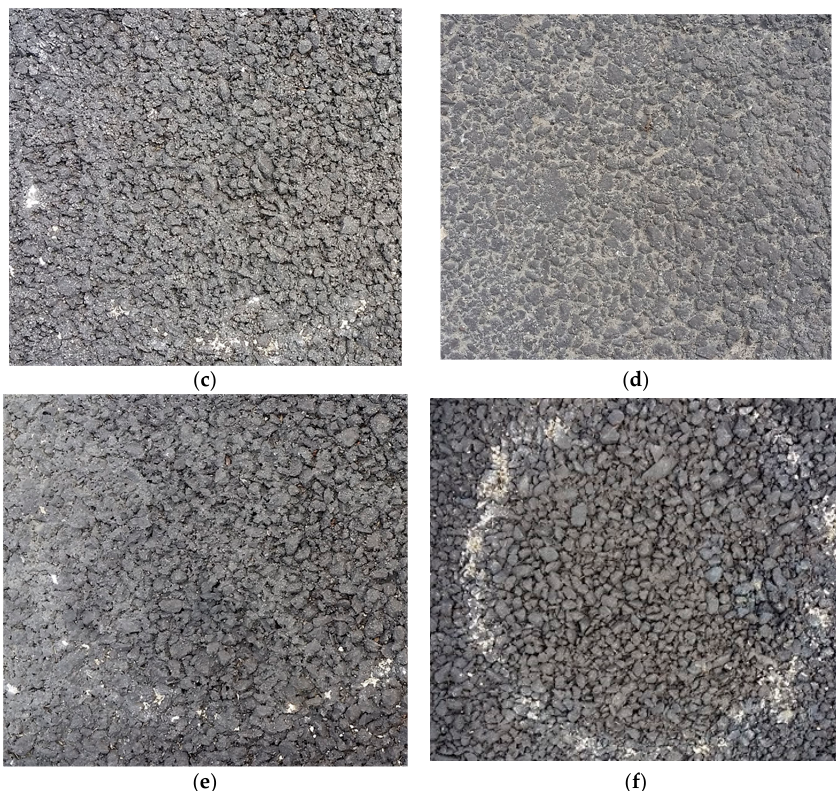
Figure 3. Images acquired with a cell phone camera of on the porous asphalt site at location 1 in ( a ), location 2 in ( b ), location 3 in ( c ), location 4 in ( d ) location 5 in ( e ) and on the porous asphalt sample shown in ( f ). Some of the images still show the silicone present from ASTM testing.